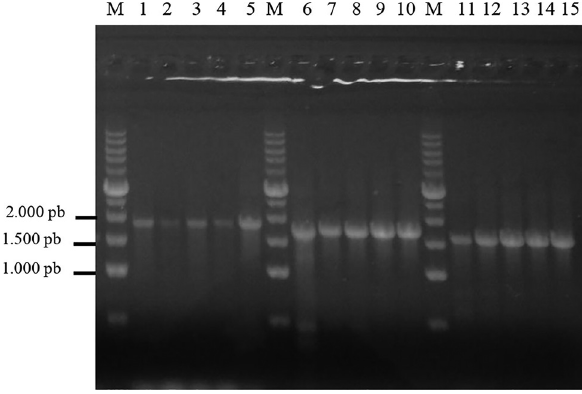
Figure 2 - Agarose gel electrophoresis of PCR products of ERG11 ampli- fied from cDNA. The reactions were done with an annealing temperature gradient. M - molecular weight marker (1 kb; Amresco). 1 - cDNA prod- ucts (1,496 bp) with no region corresponding to the signal peptide, 5-8 - cDNA products (1,400 bp) without the first transmembrane insertion and 9-12 - cDNA products (1,316 bp) without the first and second trans- membrane